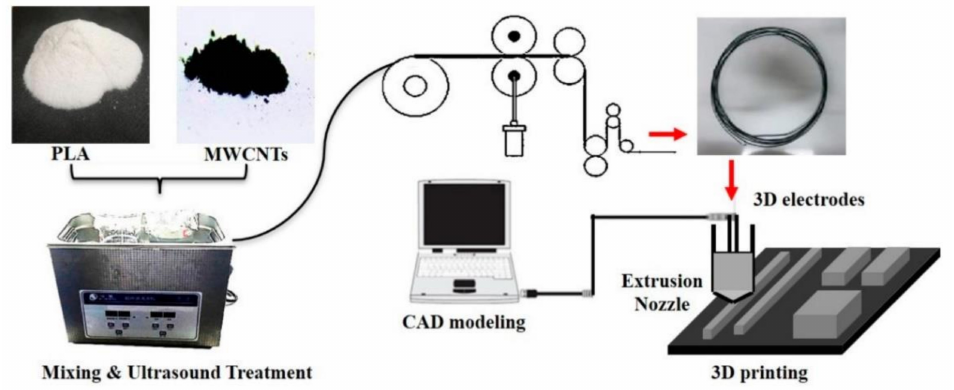
Figure 10. The fabrication process of poly lactic acid (PLA)/multi-walled carbon nanotubes (MWCNTS) composite materials by three-dimensional (3D) printing (Reproduced with permission from Reference [123], copyright 2018, MDPI